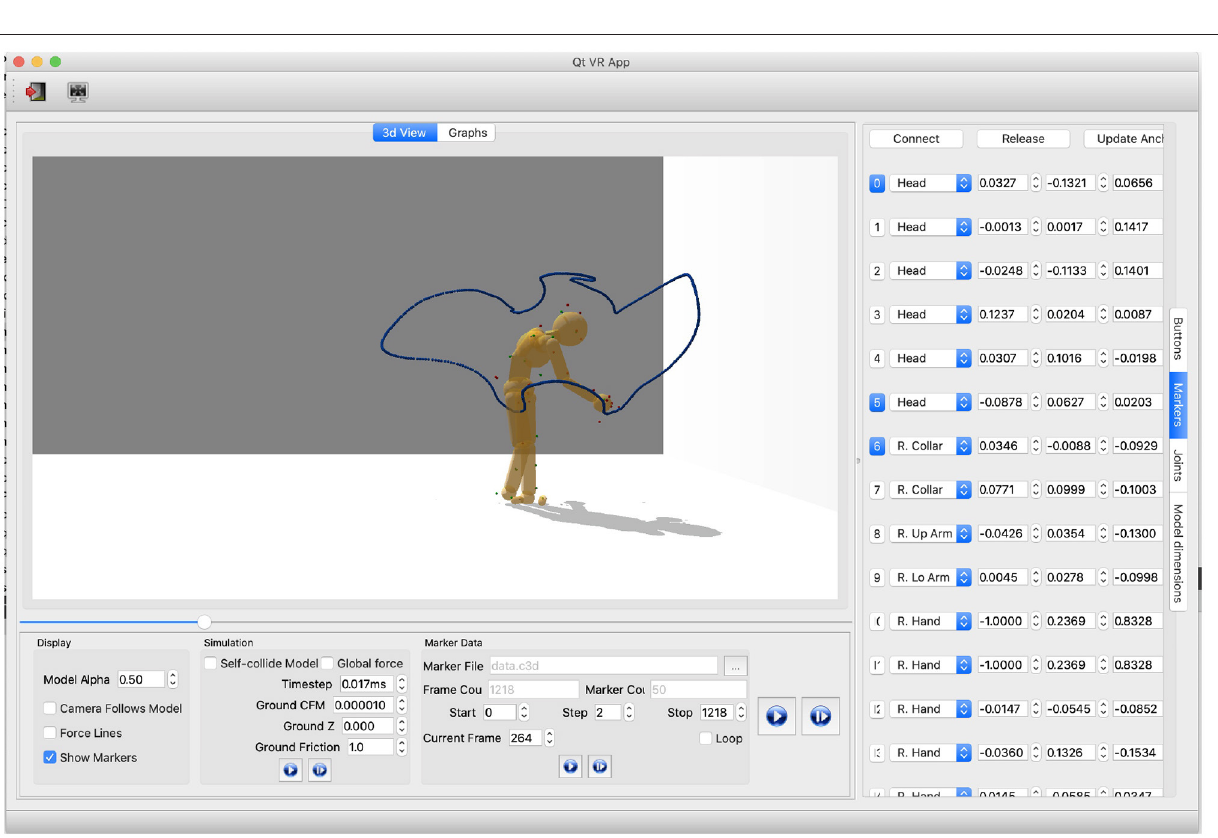
FIGURE 5 | Relevant parameters for analyzing and simulating physically-based movements must be tuned manually. Parameters of the model consist of physical world parameters, joints constraints, and the model’s body-marker relative positions. In this depiction shows how users can get the current HMD configurations by clicking the buttons on the rightmost vertical menu. “Marker” is selected, meaning the marker information is shown: (1) The first column represents marker index buttons. Buttons in blue means the corresponding markers are attached to the HDM. Users can attach/detach markers by clicking index buttons. (2) The second column shows body segments where markers are attached. Each spin box is a collective item of all body segment names. Users can use it to change the body-marker attachment relationship. (3) The three-five columns present the marker-body relative positions. Users can modify the values directly using this interface. (4) The “Connect” button and “Release” button on the top are to attach or detach all the markers, respectively. The “Update Anchor” button automatically updates the marker-body relative positions based on the current motion